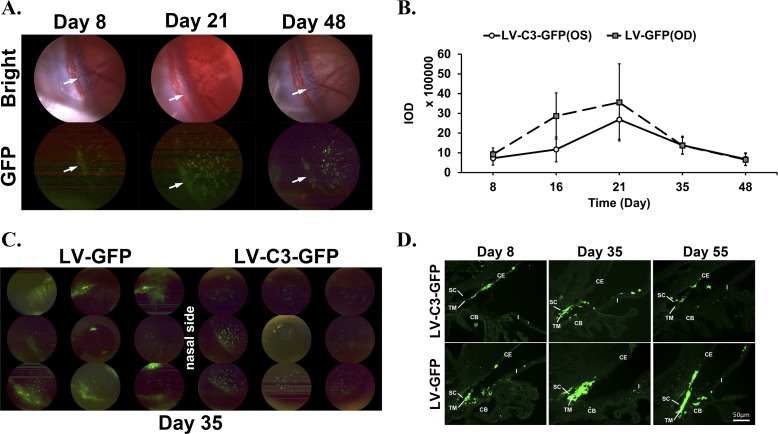
GFP expression in the anterior segment of rats. (A, C) In vivo light and fluorescence images captured by Micron III Retinal Imaging Microscope system. (D) Fluorescence images of postmortem rat ocular tissues obtained by Leica DM4 microscope. (A) GFP expression of nasal quadrant in LV-C3-GFP–injected eye of rat, at different time points. Arrows indicate fluorescence in the region of the TM. (B) IOD in nasal quadrant of rat eyes in the contralateral LV-C3-GFP and LV-GFP groups (n = 3). The peaks of GFP expression appeared on day 21. The error bars represent SEM. (C) GFP expression of all quadrants in LV-C3-GFP–injected and LV-GFP–injected rat eyes 35 days after injection. (D) Lentivirus transduction of different tissues including TM, ciliary body (CB), iris (I), and corneal endothelium (CE). SC, Schlemm's canal. Scale bar: 50 μm.